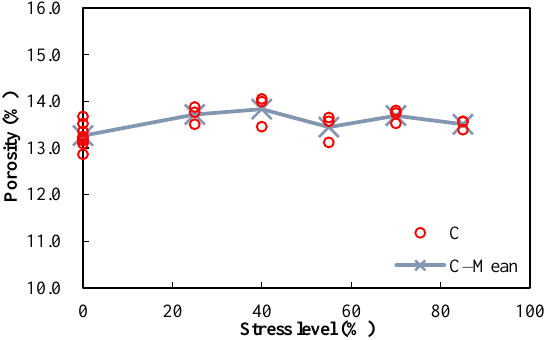
Figure 8. Porosities of damaged concrete specimens (w/c = 0.5) after different compressive stress levels.